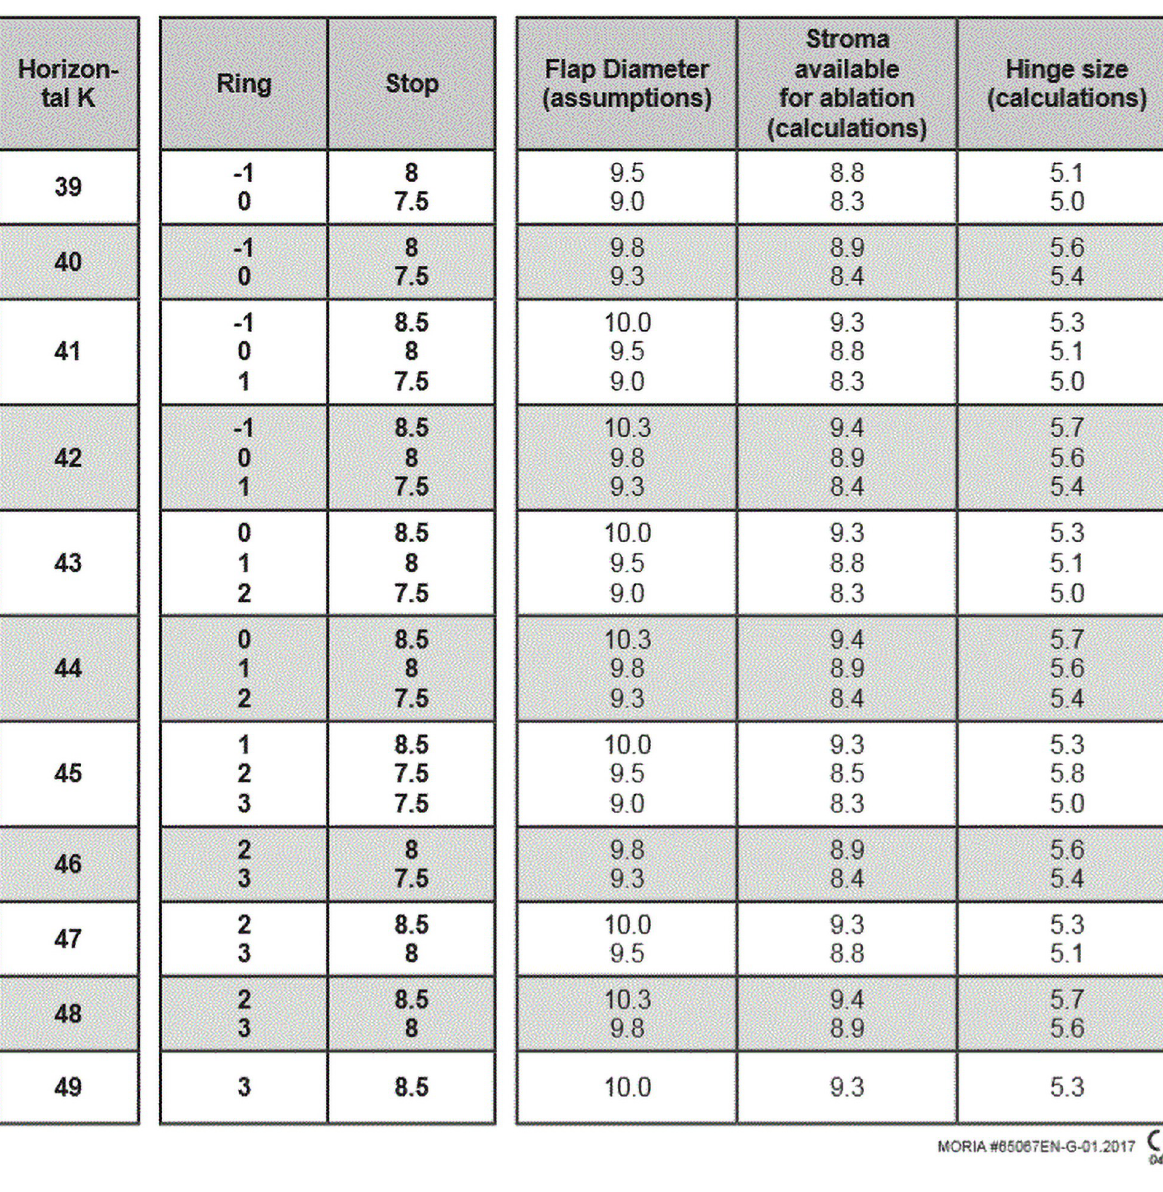
Fig 2. Expected flap size for rings and stops per microkeratome